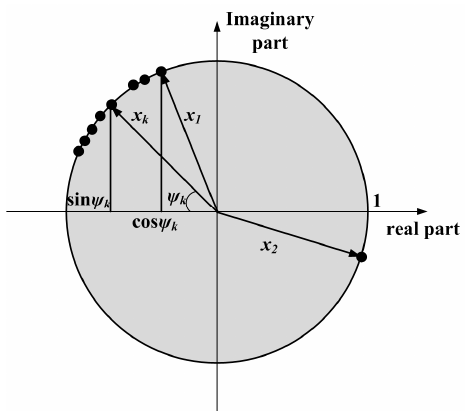
Figure 2. The representation of circular vector on the complex plane.